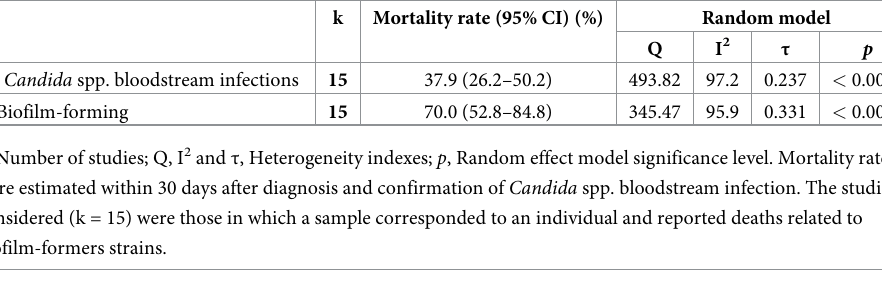
Table 3. Pooled mortality rates in bloodstream infections due to Candida spp.